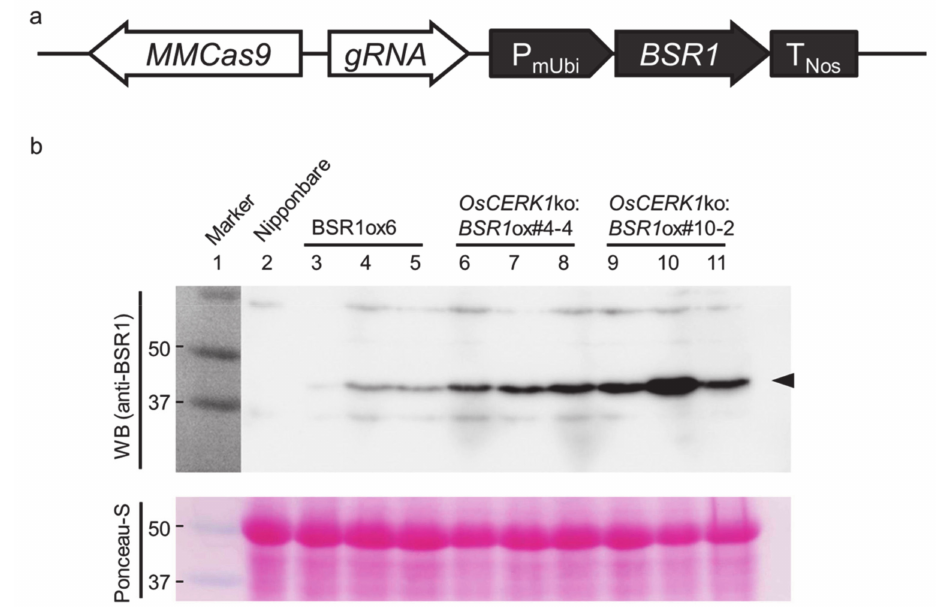
Figure 1. Generation of transgenic rice lines overexpressing BSR1 and lacking OsCERK1 . ( a ) Schematic representation of the construct for simultaneous BSR1 overexpression and OsCERK1 knockout.